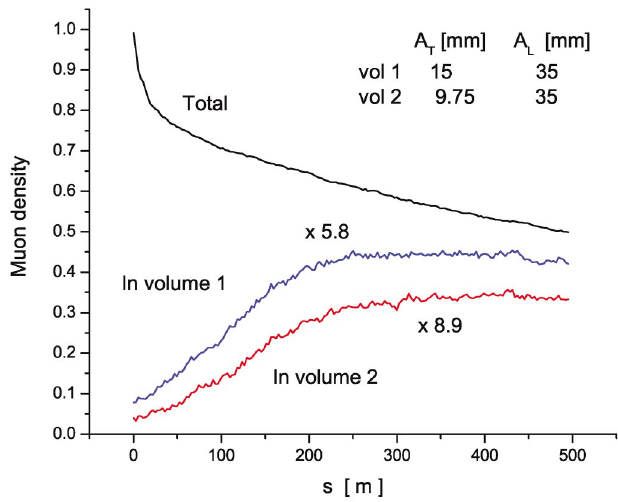
FIG. 11. (Color) Performance of RFOFO ring. Transmission and muon density into two fixed acceptance volumes. These results were obtained using a 100 (cid:5) wedge.